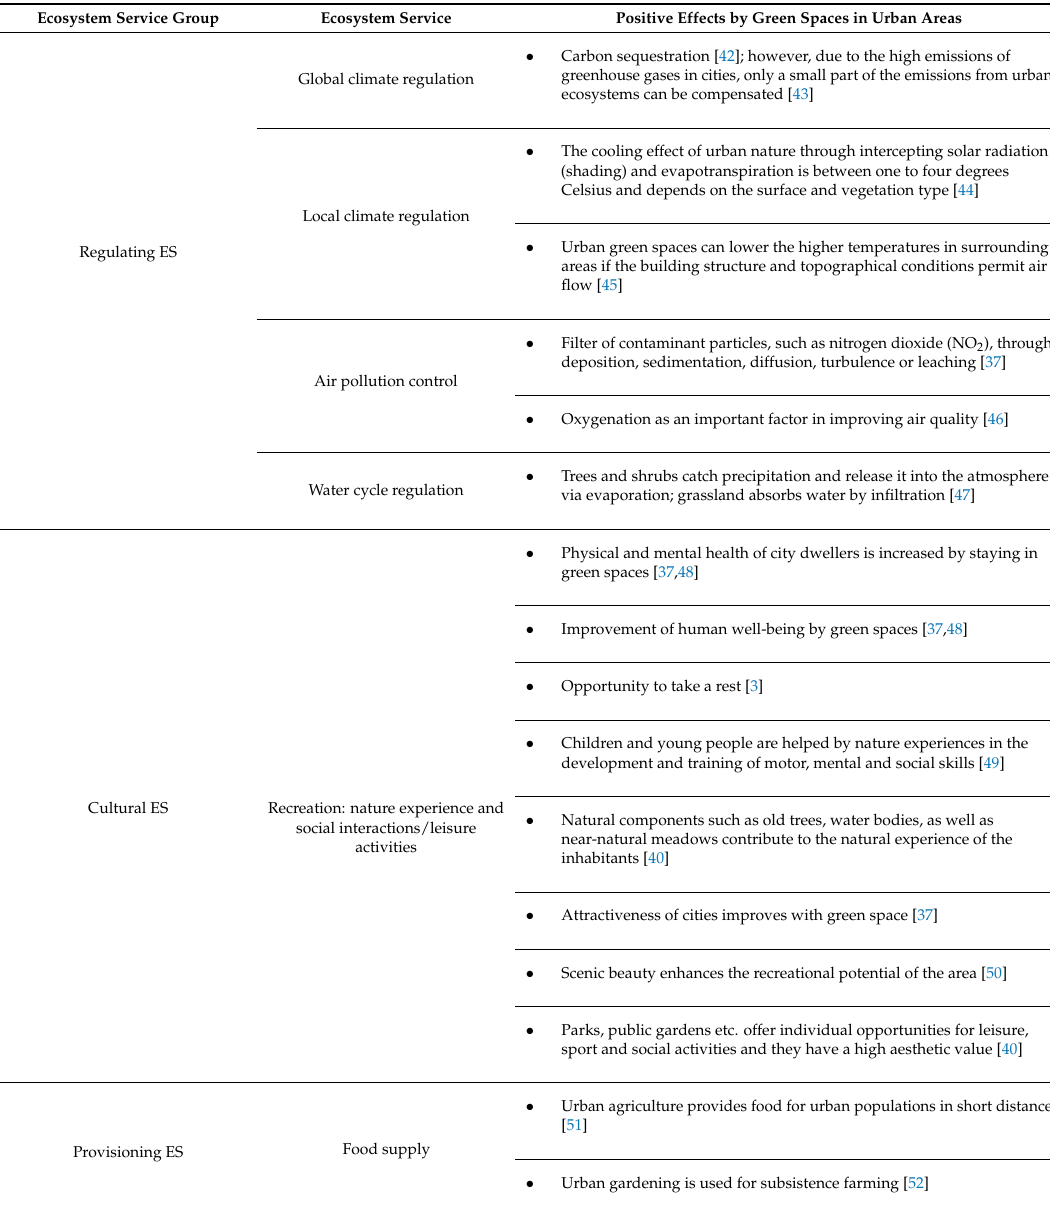
Table 4. The selected ecosystem services (ES) and its relevance for human health and physical and mental well-being in the urban context. More information on the specific ES can be found in Appendix